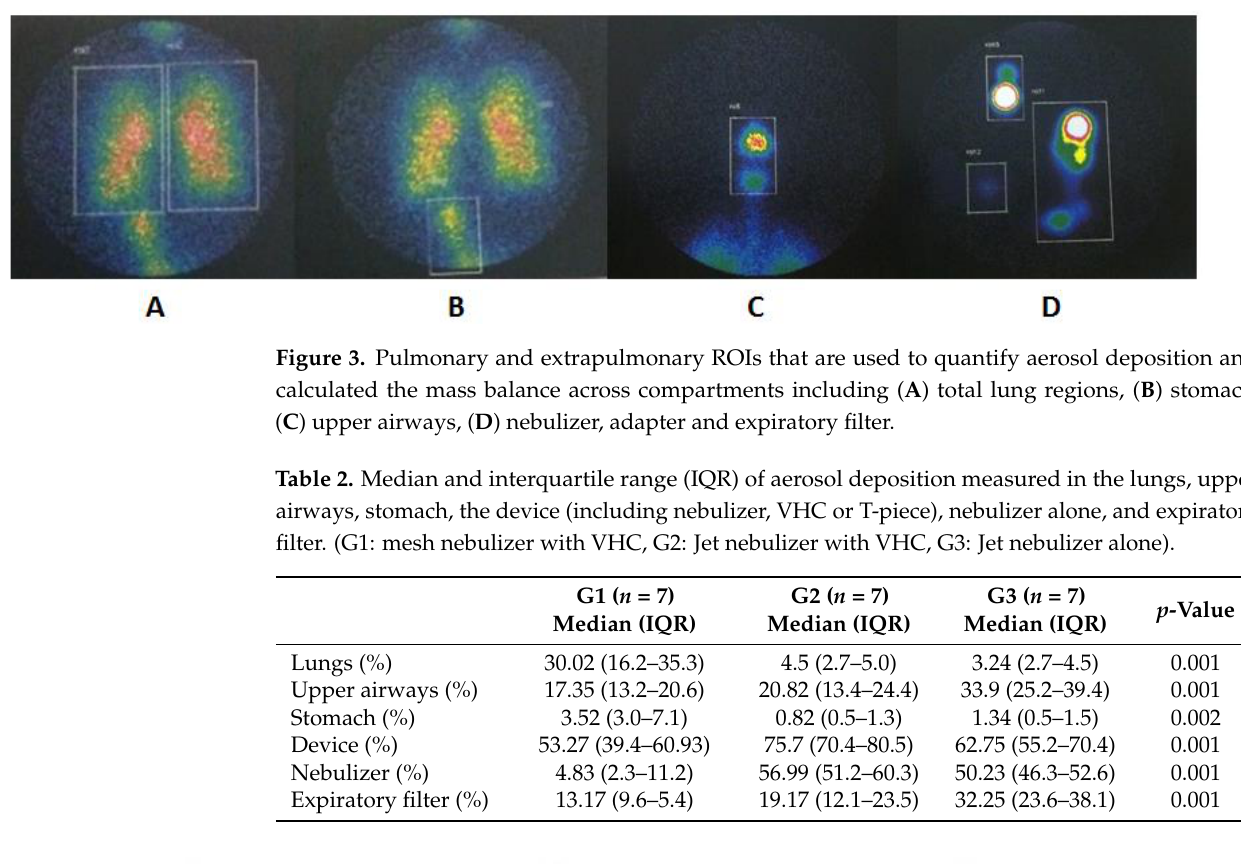
Figure 4. Representative images of posterior thorax post-nebulization with each device configuration. ( A ) G1: Mesh nebulizer with VHC, ( B ) G2: Jet nebulizer with VHC, ( C ) G3: Jet nebulizer alone (Jet nebulizer without VHC).